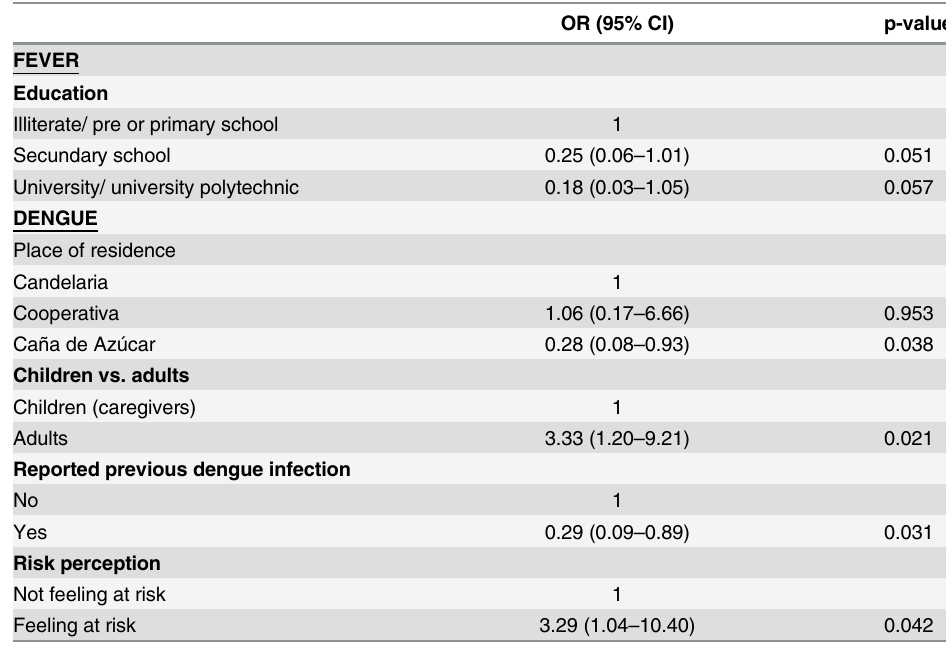
Table 1. Final model of factors independently associated with first intended action in the case of fever and dengue. Final model of factors independently associated with visiting a doctor as the fi rst intended action versus home treatment in the case of fever and